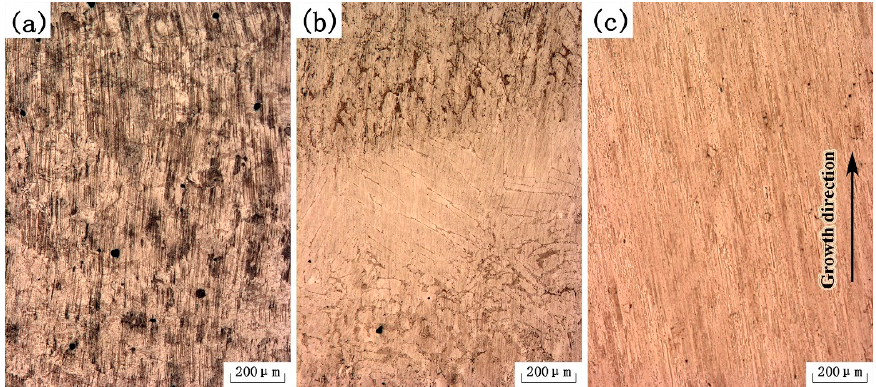
Figure 5. Longitudinal microstructures in the ( a ) annealing region, ( b ) transition region and ( c ) DS region during the general seeding process at 10 μ m/s.